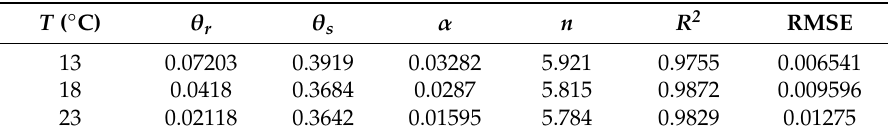
Table 3. Fitting parameters of the soil-water characteristic curve (SWCC) from the soil column and Ku-pF